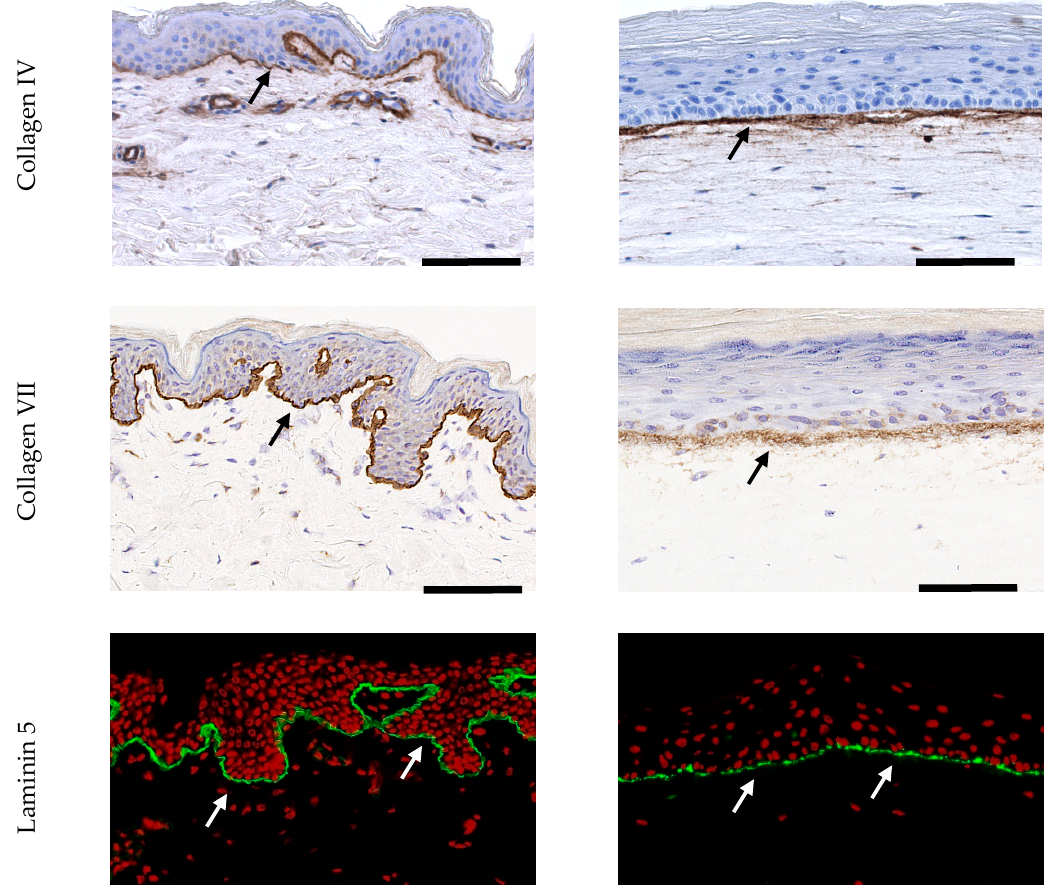
Figure 3. Characterization of the DEJ in NHS and T-Skin™. Collagen IV and VII immunohistochemistry analysis was performed on paraffin sections and laminin-5 immunofluorescence analysis was performed using cryostat sections. Arrows indicate the localization of specific labelling; scale bars indicate 100 µm.